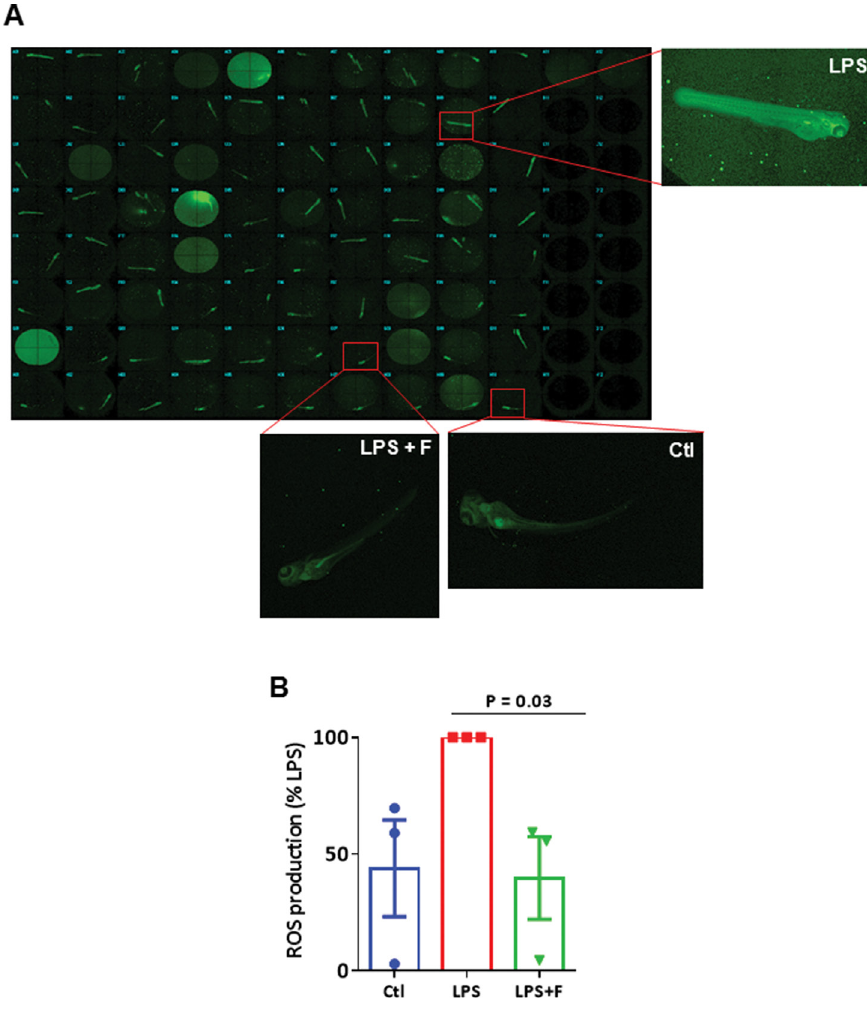
Figure 7. Identification of fasudil using a high-throughput drug screen. (A) A representative image of the 96-well readout for ROS production obtained from our in-house robotic drug screening platform is shown. (B) Fasudil, a lead hit identified using the screen, rescued LPS- induced ROS production, tail fin edema and mortality in our zebrafish sepsis model (n =